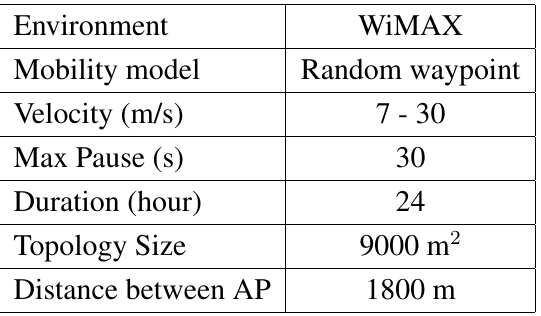
Table 6. Parameters for the mobility models in the handoff